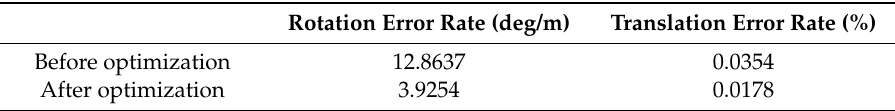
Table 3. Accuracy with or without